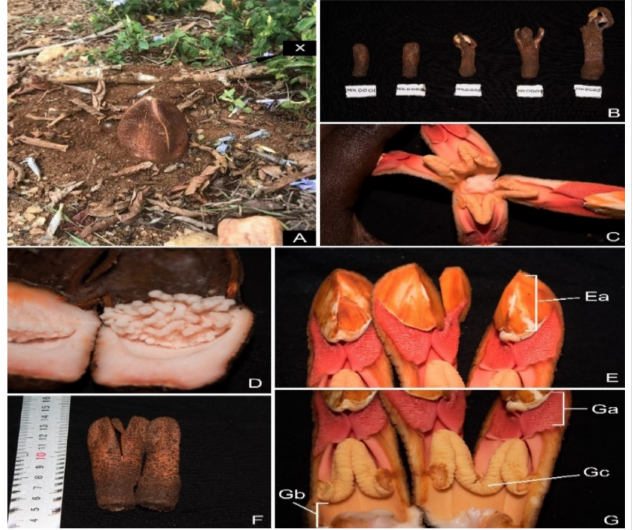
Figure 1. Flower of Hydnora abyssinica : ( A ) H. abyssinica plant growing, ( B ) images of other young H. abyssinica plant, ( C ) internal part of the flower, ( D ) fruit containing seeds white like rice, ( E – G ) floral parts; Ea —osmophores, Ga —androecial part, Gc —antheral rings, ( F ) outer part of the H. abyssinica